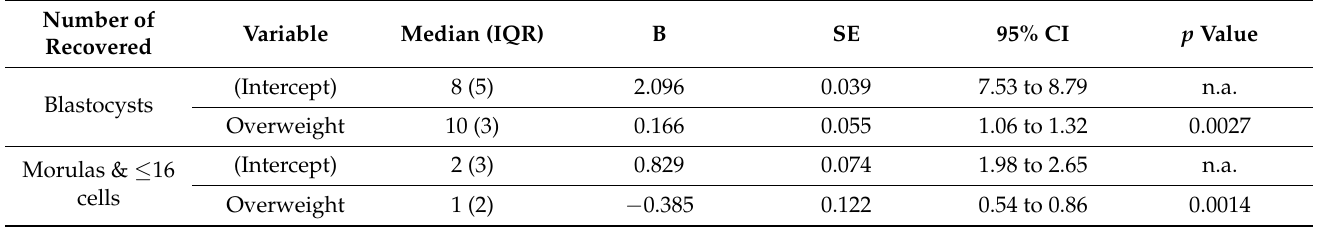
Table 5. Univariate Poisson regression for the number of recovered blastocysts and for the number of recovered morulas & ≤ 16 cell embryos & degenerates on embryonic day 4 in fertilized female mice (i.e., mated and ovulating females with at least one embryo in the reproductive